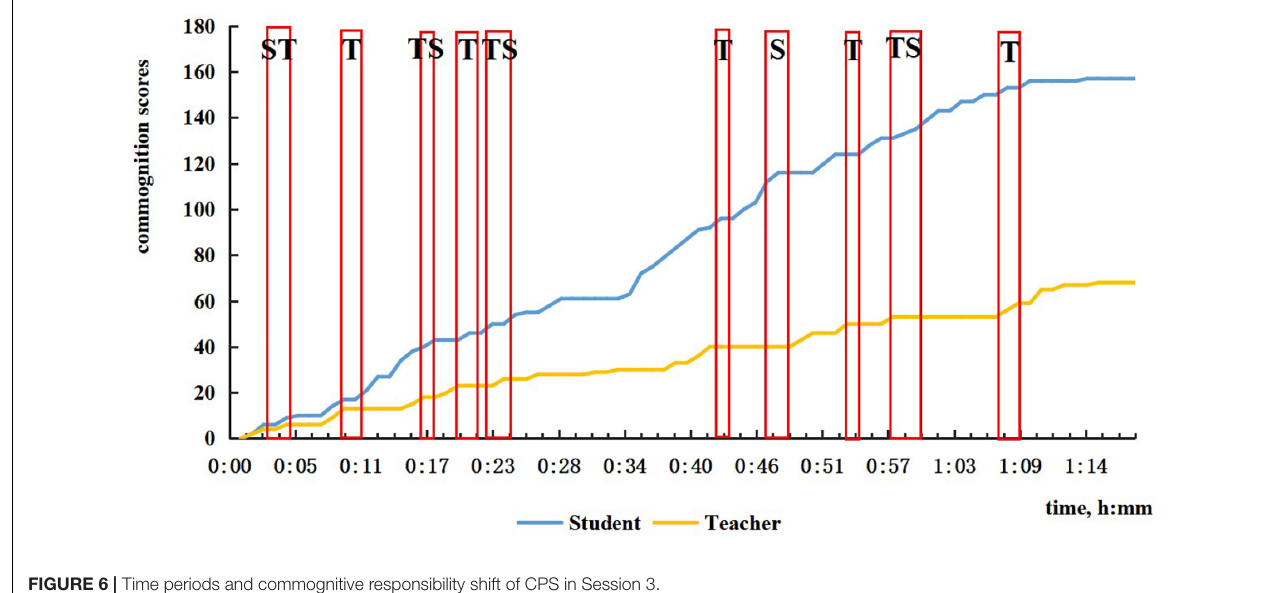
FIGURE 6 | Time periods and commognitive responsibility shift of CPS in Session 3.